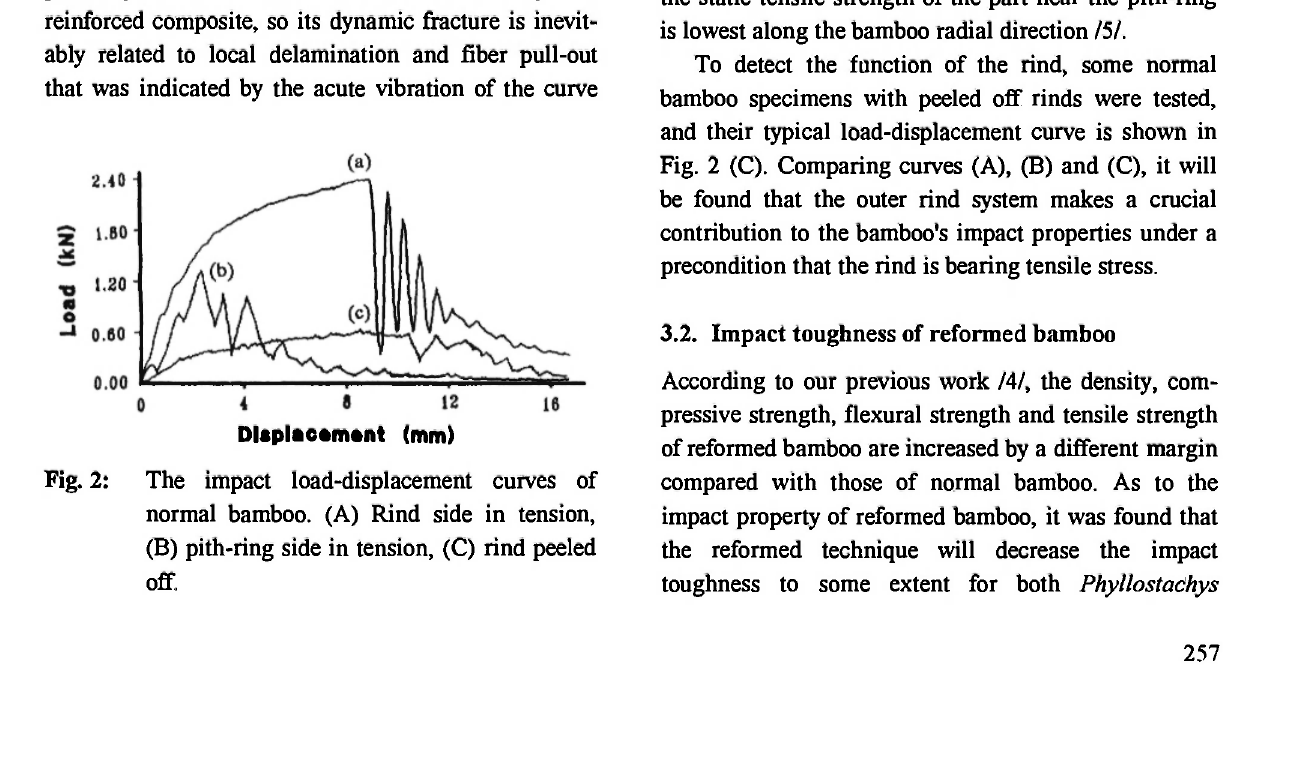
Fig. 2: The impact load-displacement curves of normal bamboo. (A) Rind side in tension, (B) pith-ring side in tension, (C) rind peeled off.